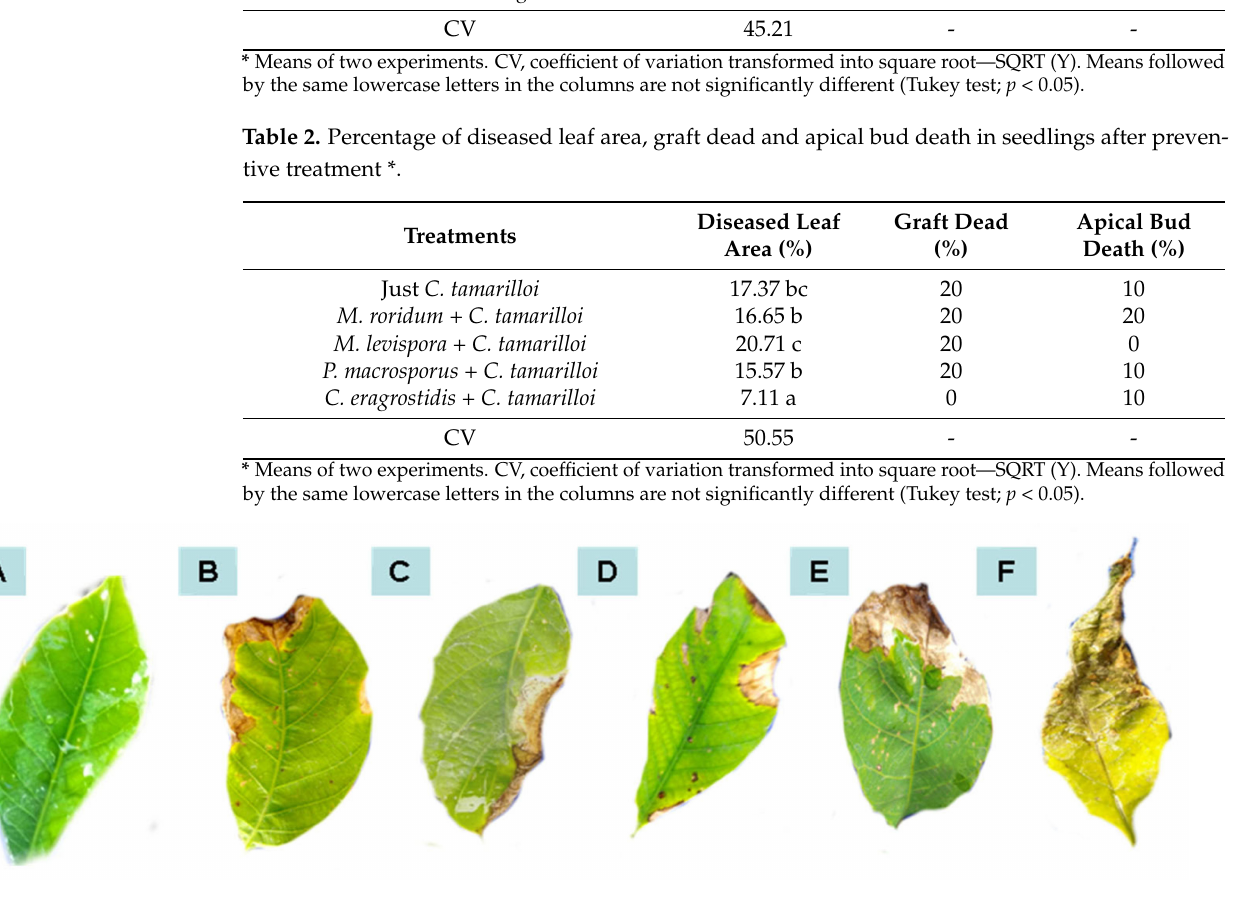
Figure 1. Leaf area affected by anthracnose after curative treatments with water ( A ), Colletotrichum alone ( B ), P. macrosporus —Isolate 37/06 ( C ), C. eragrostidi —Isolate 47/06 ( D ), M. levispora —Isolate 33/08 ( E ), and M. roridum —Isolate 03/10 ( F